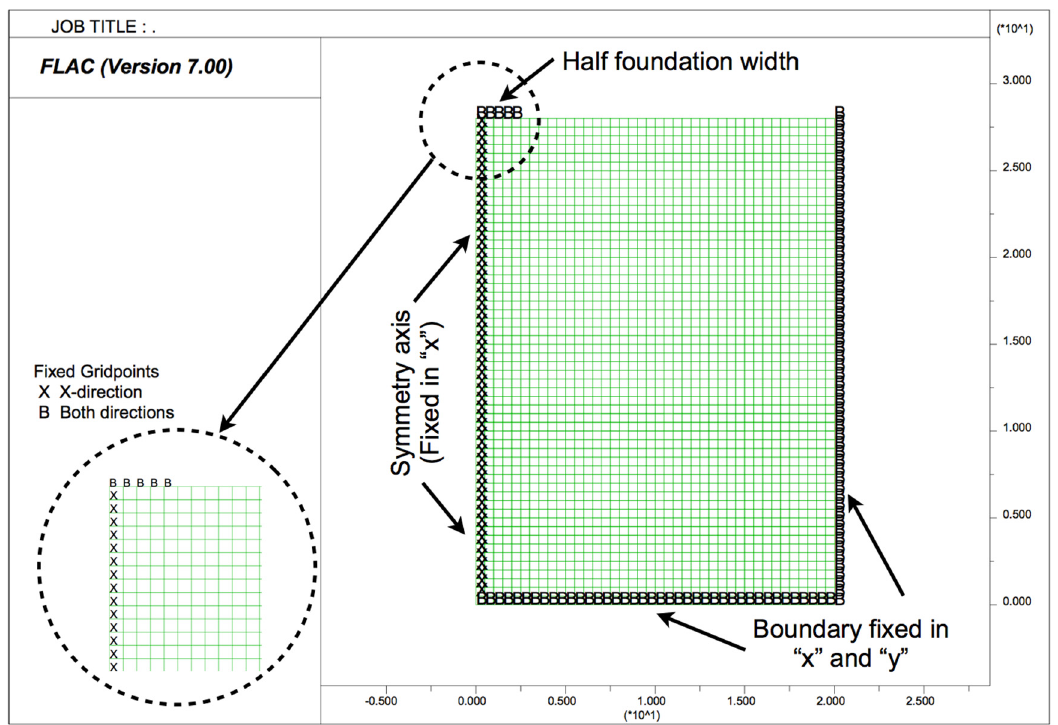
Figure 2. The 2D model employed in the numerical calculation ( x –axis and y –axis units in meters). Table 1. Summary of the adopted parameters.